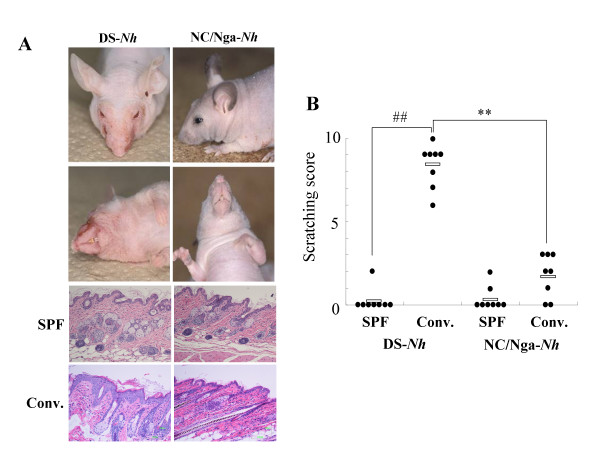
Disease symptoms in DS-Nh and NC/Nga-Nh mice. (A) Clinical features of DS-Nh and NC/Nga-Nh mice at 20 weeks of age kept under conventional or SPF conditions. (B) Evaluation of scratching and rubbing behavior in both strains at 20 weeks of age (n = 8) (SPF, kept under SPF conditions; Conv, kept under conventional conditions). White bar represents mean value of the grouped mice. (**, ##: significant differences at p < 0.01).